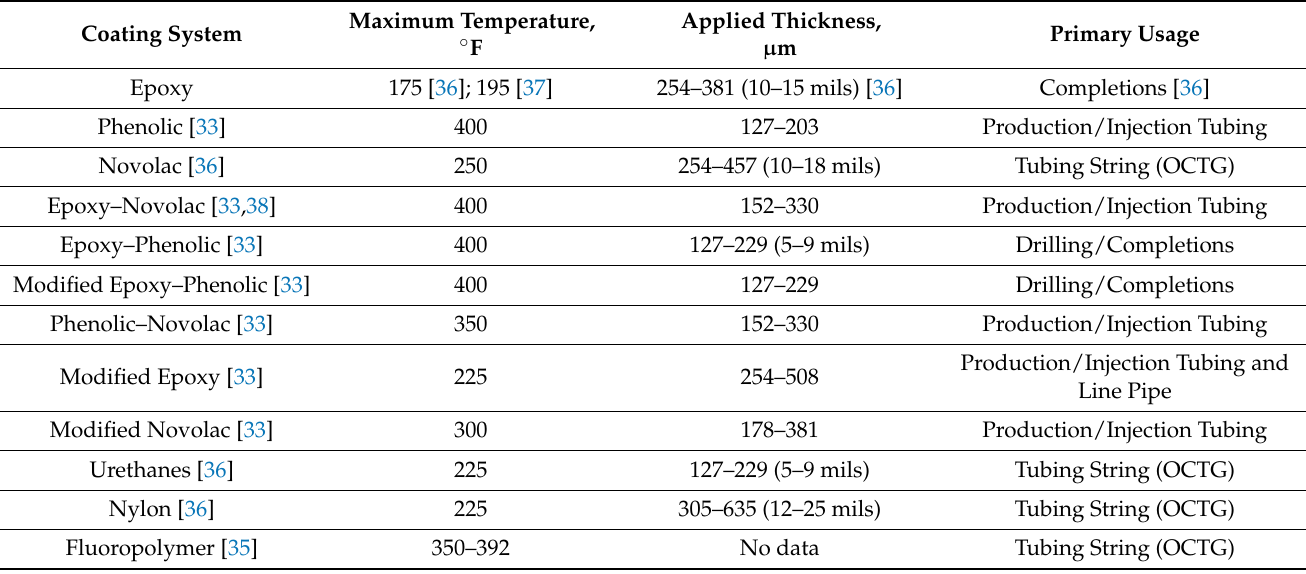
Table 2. Coating systems and their application in the protection of downhole